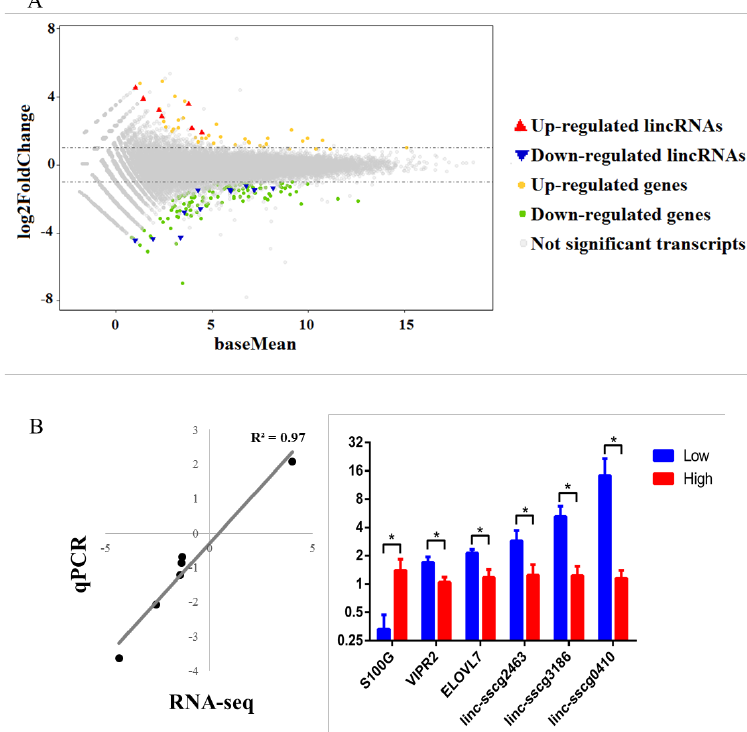
Figure 2. Differential expression analysis of annotated genes and lincRNAs between high- and low- FE pigs. ( A ) The distribution of fold changes in gene expression. Genes (lincRNAs) with absolute log2FoldChange > 1 are indicated in orange (red) and those with log2Foldchange < −1 are indicated in green (blue). ( B ) Quantitative-PCR (qPCR) analysis results of six selected DE genes and lincRNAs. Left: Scatter diagram showing the log2FC correlation of RNA-seq and qPCR. Right: Relative expression of selected DE genes and lincRNAs. Statistically significant differences between high- and low-FE pigs are indicated by * ( p value < 0.05).